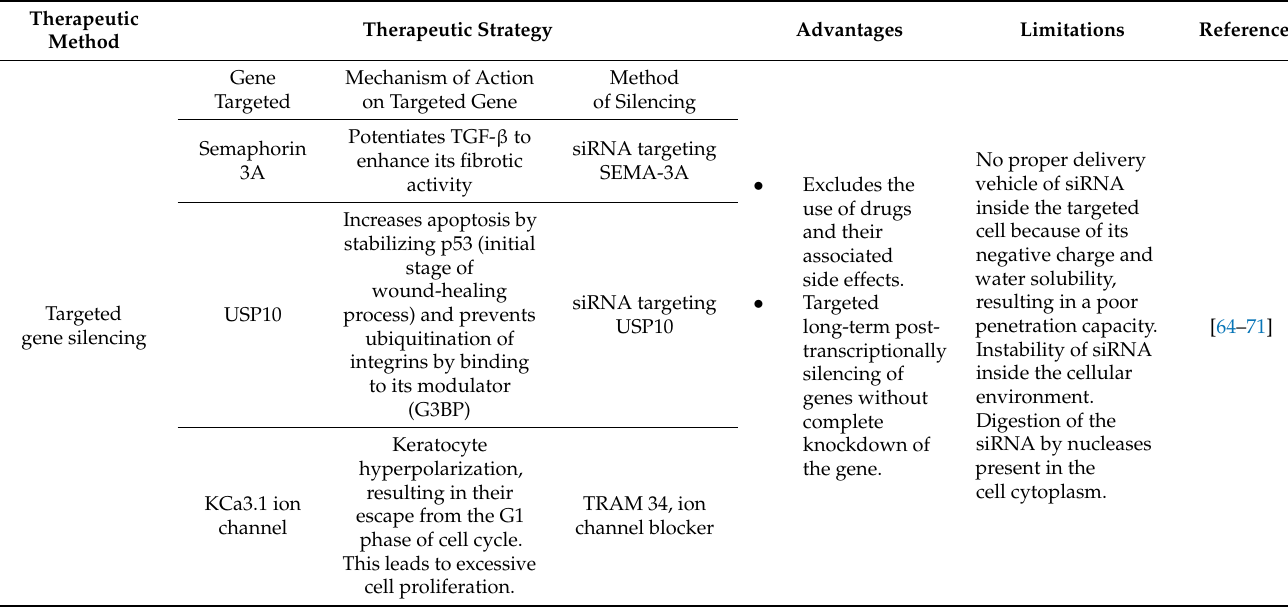
Table 2. Targeted gene knockdown and protein overexpression as therapeutic tools for preventing corneal